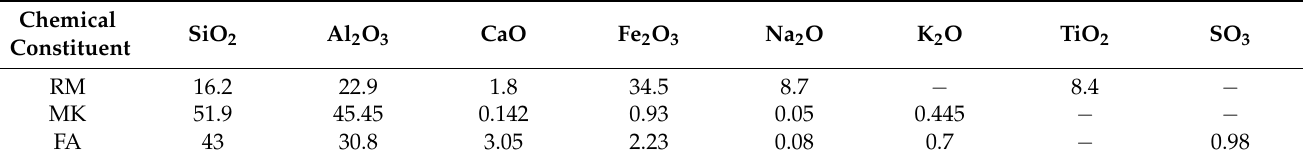
Table 1. The main chemical composition of the raw materials